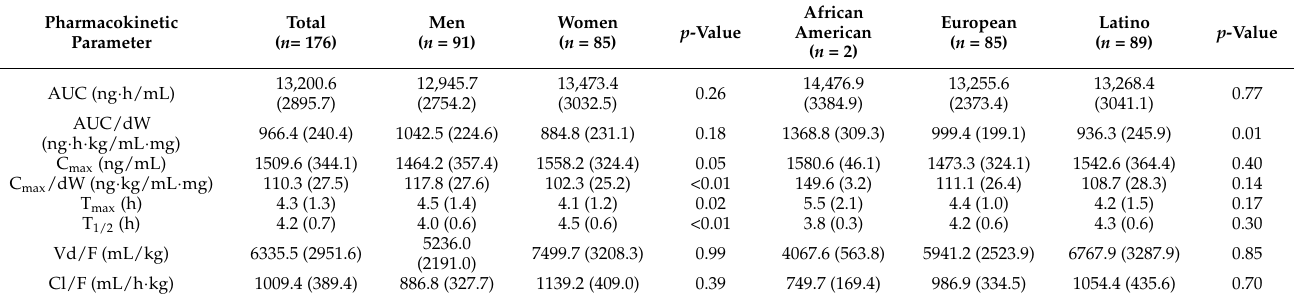
Table 2. Pharmacokinetic parameters of metformin after a single 850–1000 mg oral dose.